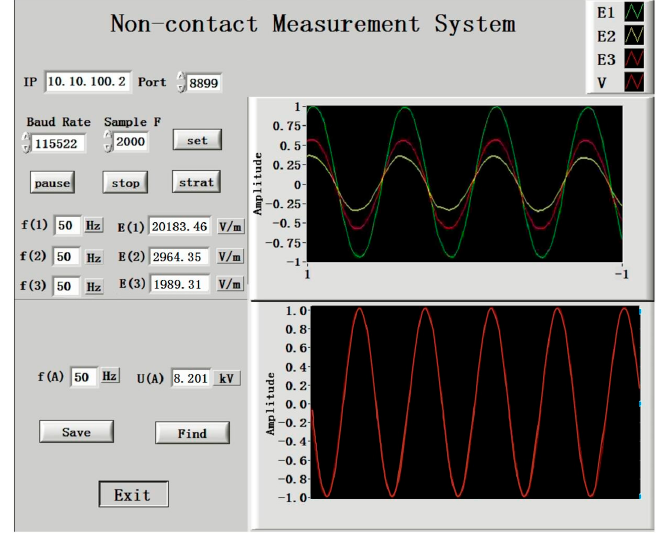
Figure 11. The front panel of the voltage measurement system.